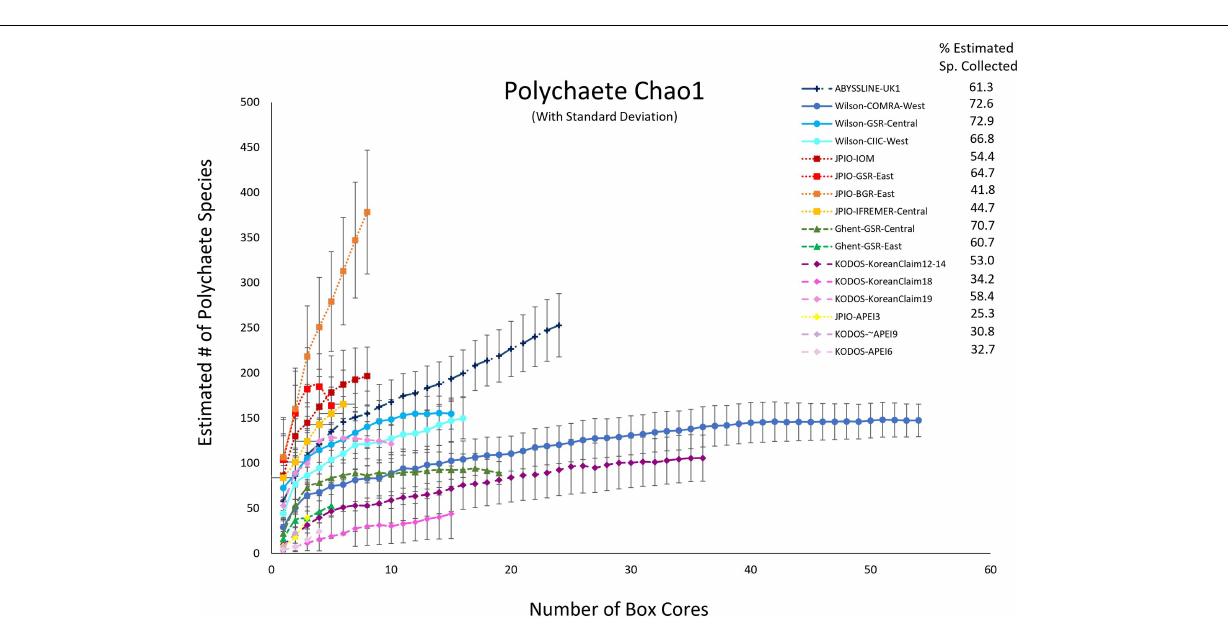
FIGURE 6 | Chao 1 (+SD) estimates of polychaete species richness as a function of number of box cores collected at 16 sites across the CCZ region. Note that KODOS-KoreanClaim data come from a single site sampled in different years. Data sets considered to have been sampled with similar protocols and to have used a consistent taxonomy are indicated by similar